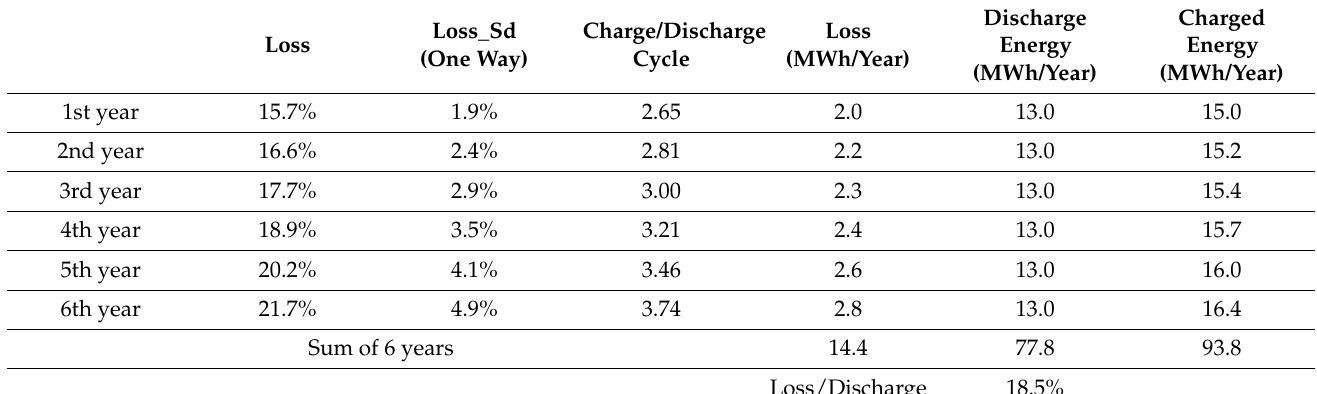
Table 4. Degradation calculation.